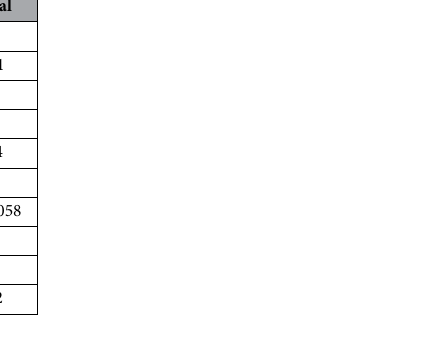
Table 7. Correlation coefficients of adjacent